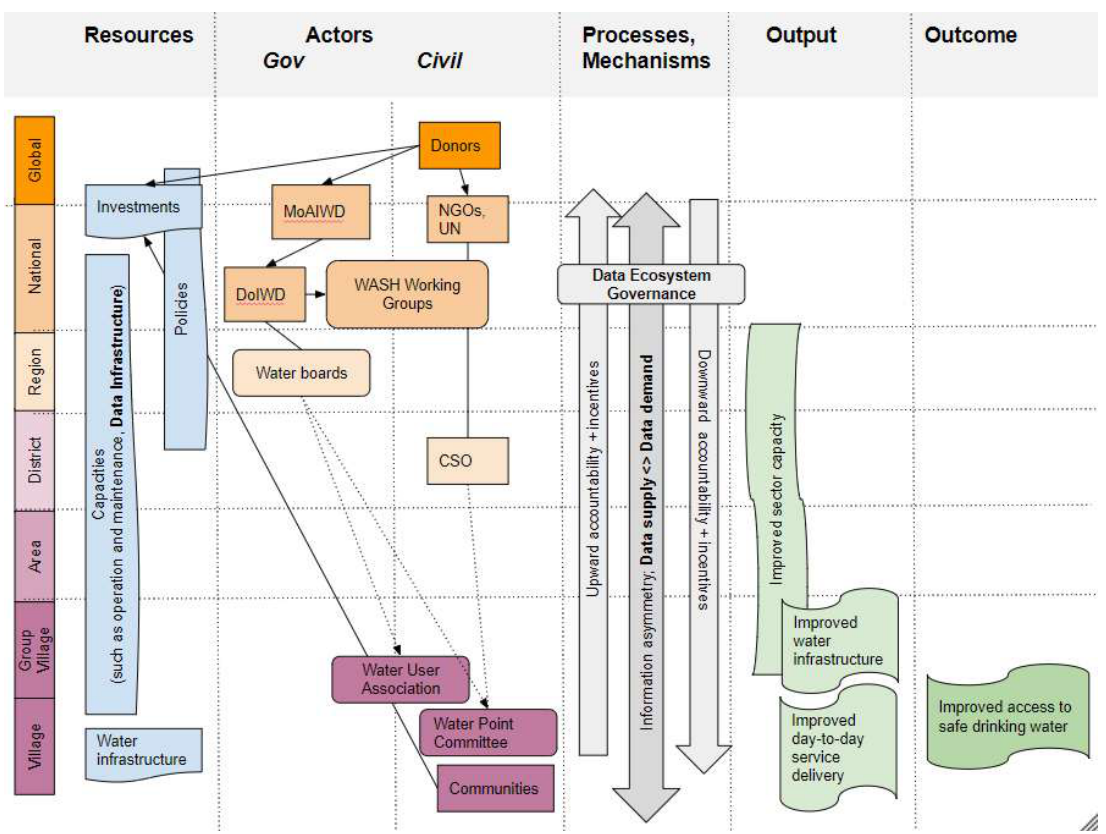
Figure 2. Political economy analysis of water supply in Malawi. The dimensions of the data ecosystem are shown in bold. There is a large overlap between the actors involved in the WASH sector and those that have data, but some alternative data providers are outside the group of actors directly involved and these are not depicted. CSO Civil Society Organization, MoAIWD Ministry of Agriculture, Irrigation and Water Development; DoIWD Department of Irrigation and Water Development. The diagram is developed by the authors and builds on insights from [41].